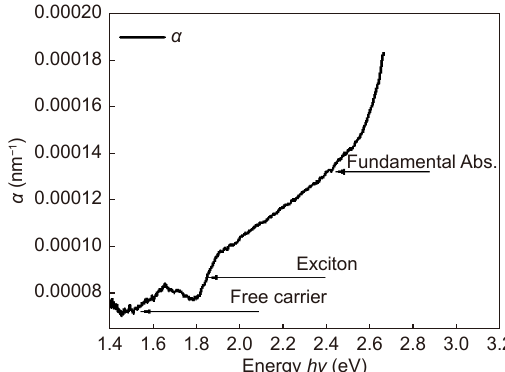
Fig. 16 | Absorption regions for fabricated silicon thin